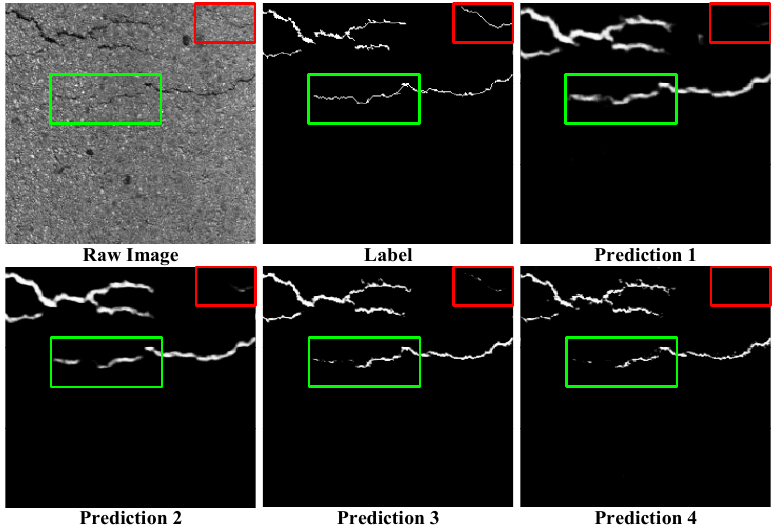
Figure 1. Visual presentation of the two challenges in crack detection: poor performance and com- pleteness in extracting tiny cracks (red boxes); rougher and thicker crack boundaries (green